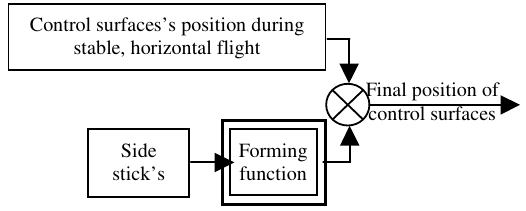
Fig 3. The schematic of control law using forming